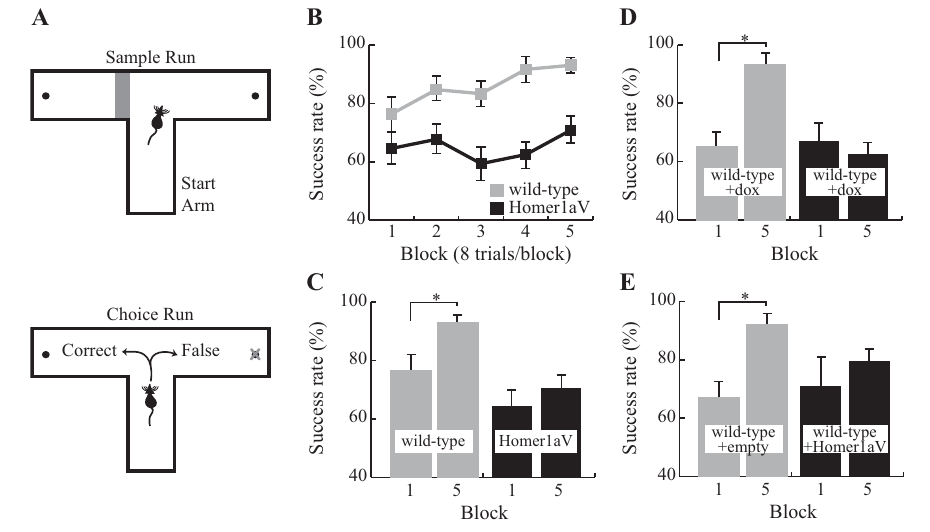
Figure 4. Impaired spatial working memory during sustained expression of Homer1a . ( A ) Each trial on the delayed match to sample task, administered on a T-maze, consists of two runs. During the first (sample) run (upper panel) the mouse is forced to choose one of the two target arms by blocking the other arm. In the second (choice) run (lower panel), it is rewarded if it chooses the previously unvisited arm. ( B ) Wild-type (N=9) but not TgH1aV.Fb (N=12) learned the task. TgH1aV.Fb mice, however, showed the natural preference of rodents to visit the previously unvisited arm on this task, as shown by significantly better than chance level (50%) of spontaneous alternation during the first training block. ( C ) The success rate of wild-type increased over the course of the training. TgH1aV.Fb mice, however, started and finished the training at the same success rate without any significant learning throughout the training. ( D ) To question if the working memory deficit can be recovered upon reversal of the transgenic expression in the adult animal, we tested the wild-type (N=7) and TgH1aV.Fb mice (N=7) after giving dox for 4 weeks, starting 4 months after birth, and tested them on the T-maze. After five blocks of training, wild-type but not TgH1aV.Fb mice learned the task. ( E ) To study if the Homer1a expression in hippocampus alone could cause the working memory deficit, we virally expressed H1aV in hippocampi of adult wild-type mice for 4 weeks before testing the mice on the T-maze. Mice injected with an empty viral construct (N=6) learned the task just like the uninfected wild-types (gray bars). Mice expressing H1aV in the hippocampus (N=7, black bars), however, failed to learn the task, even after five blocks of training.